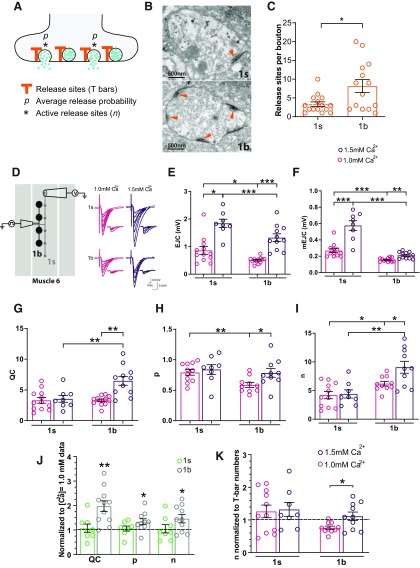
The upper limit for n is set by the number of T-bars. A, Schema of release sites at a synapse. Active release sites (*) contribute to the average release p. B, Electron micrographs (EMs) of a 1s (top) and a 1b (bottom) bouton, with T-bars (synapses) indicated with arrowheads. C, Average number (±SEM) of release sites for 1s and 1b boutons, determined from the T-bar counts from the EM data. See Materials and Methods, and Extended Data Figure 2-1 for other examples. D, [Ca2+]e was raised from 1.0 to 1.5 mm in focal macropatch recordings in CS larvae. Right, Sample recordings from single 1s and 1b boutons revealed increases in the amplitudes of EJCs and mEJCs at both bouton types under higher calcium concentrations. E, Average EJC (±SEM) for 1s and 1b recordings. F, Average mEJC (±SEM) for 1s and 1b recordings. G, As [Ca2+]e was raised, calculations of QCs revealed no increase in 1s QC, whereas there was an increase in 1b QC. H, I, There were no increases in p (H) or in n (I) at 1s boutons, whereas there were increases in both p (H) and n (I) at 1b boutons, contributing to the increase in 1b QC (G). J, We observed that at 1s boutons, all the release sites were already activated at 1.0 mm [Ca2+]e, with no additional increase being observed when [Ca2+]e was further raised. At 1b boutons, not all of the release sites were activated at 1.0 mm [Ca2+]e, whereas they were all activated when [Ca2+]e was further raised. K, We generated a graph to test whether values of n approached the number of T-bars per bouton as [Ca2+]e was raised, by normalizing n (Fig. 2I) to the number of T-bars per bouton (Fig. 2C). The dashed line at 1.0 is representative of when n equates to the number of T-bars per bouton. These results indicate that n is limited by the number of T-bars per bouton type. *p < 0.05; **p < 0.01; ***p < 0.001; Student’s t test. 1.0 mm [Ca2+]e data are the same as in Figure 1, shown here for comparison. Graphs show individual data points (animals), and all error bars are ±SEM.